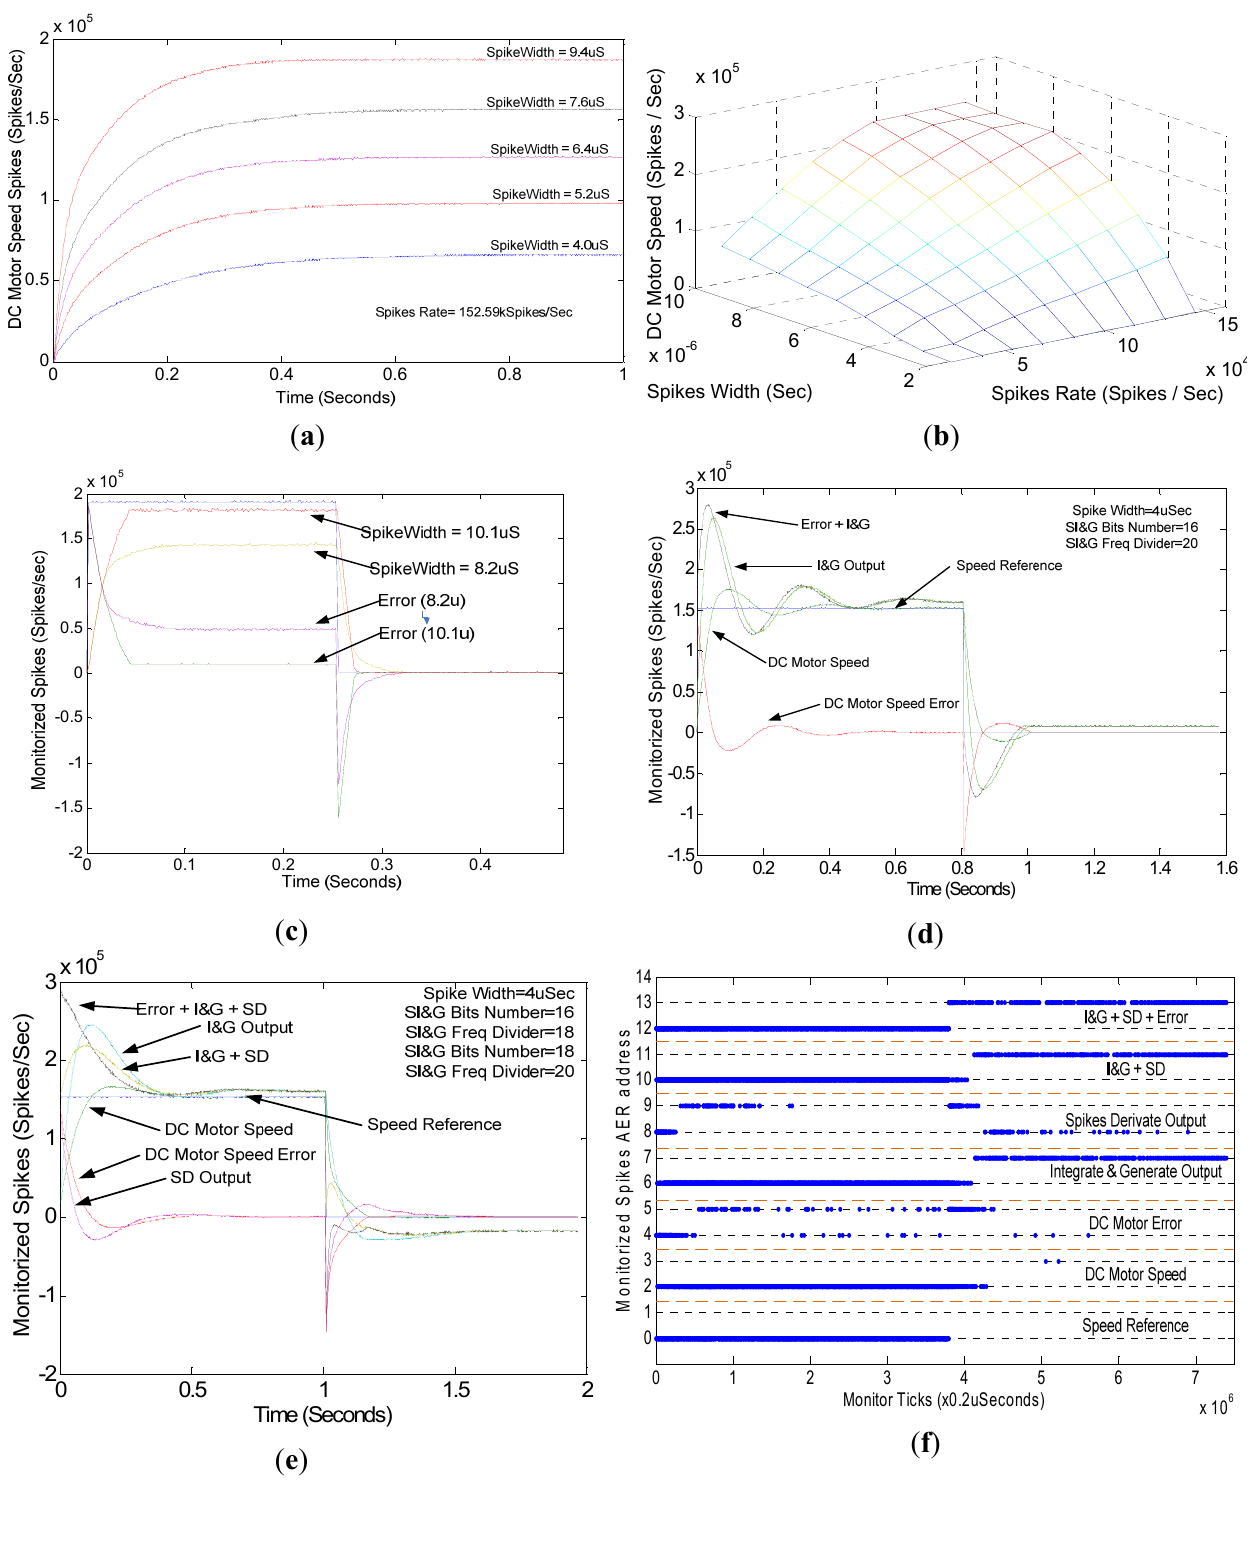
Figure 16. Experimental results: ( a ) Open-loop responses; ( b ) Static characteristic; ( c ) spikes-based P control; ( d ) spikes-based PI control; ( e ) spikes-based PID controller; ( f ) monitored AER